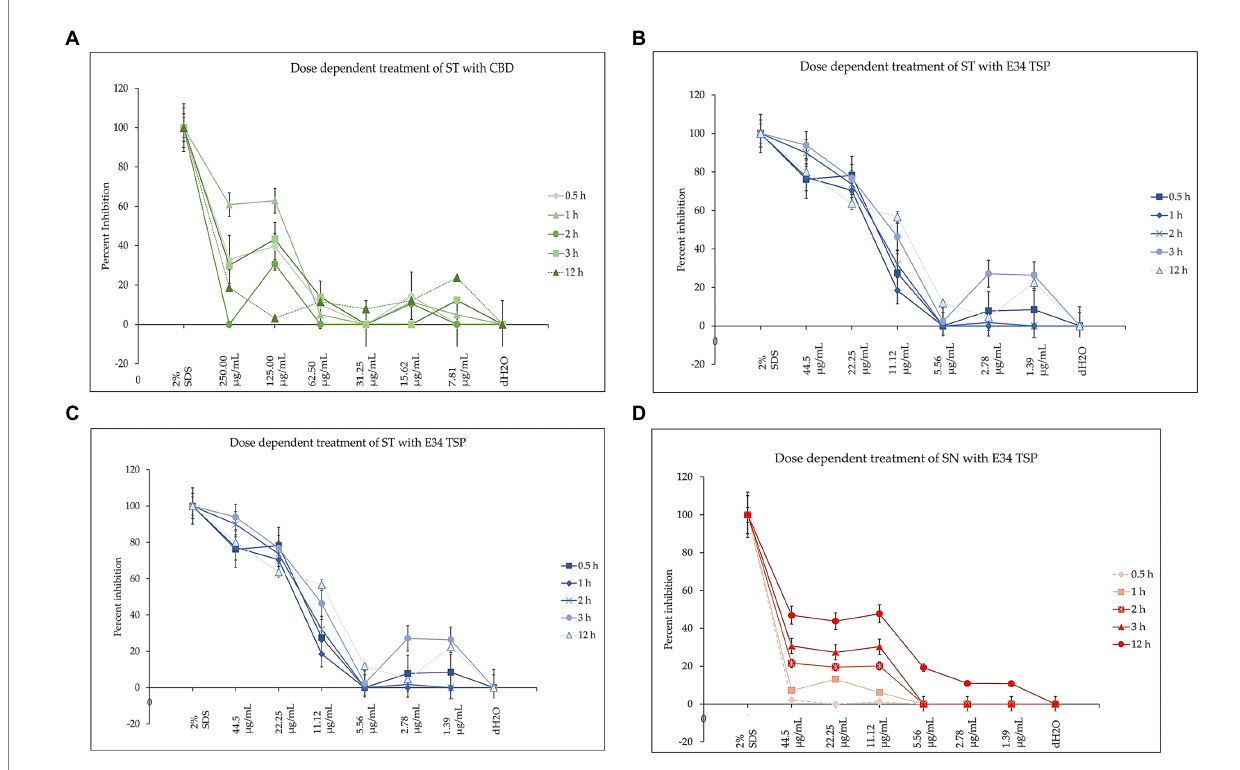
FIGURE 10 (A) The effect of CBD extract on S . Typhimurium presented as means ± standard deviation. Data shown are from three independent experiments expressed as means ± SEM. As can be seen, CBD extract although showed slightly higher inhibition at higher doses, it seemed not to exhibit time dependent inhibition of S . Newington. (B) The effect of E34 TSP on S . Typhimurium presented as means ± standard deviation. Data shown are from three independent experiments expressed as means ± SEM. As can be seen, E34 TSP seems to inhibit S . Typhimurium in both time and dose dependent nature. (C) The effect of CBD extract on S . Newington presented as means ± standard deviation. Data shown are from three independent experiments expressed as means ± SEM. As shown, CBD extract did not show any significant inhibition of S . Newington in all treatments. (D) The effect of E34 TSP on S . Newington presented as means ± standard deviation. Data shown are from three independent experiments expressed as means ± SEM. As can be observed, E34 TSP seems to inhibit S . Newington in both time and dose dependent